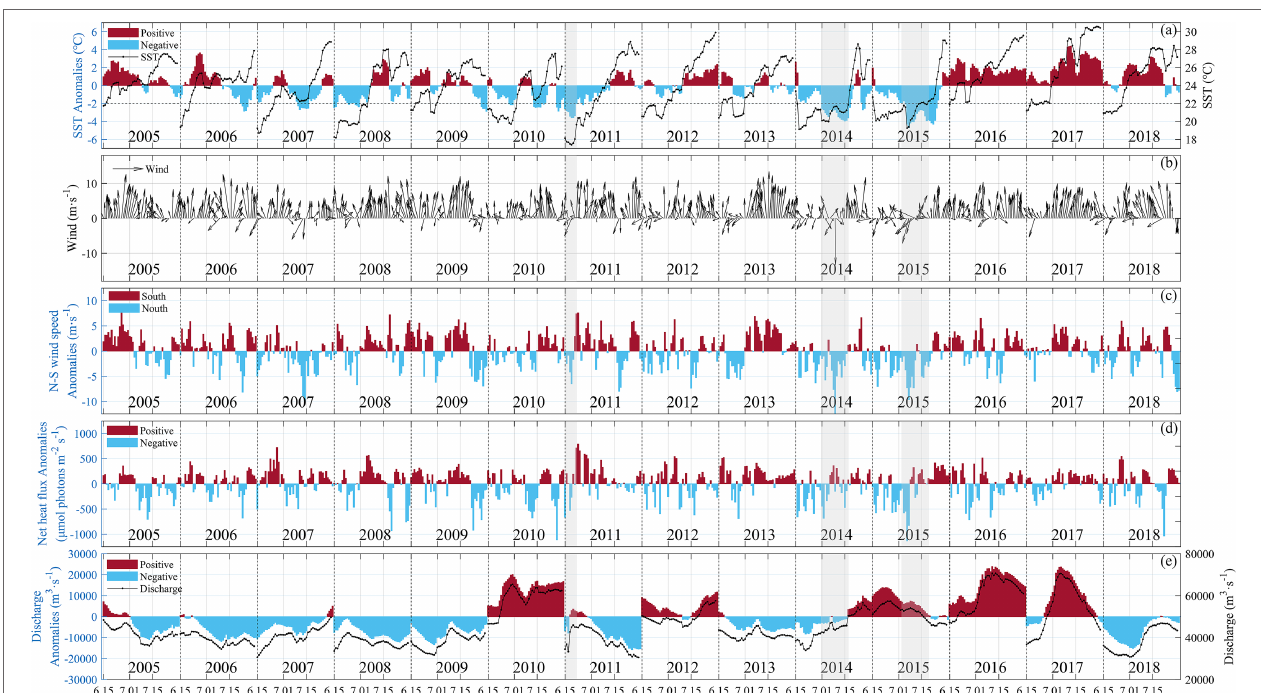
FIGURE 5 | Temporal variations of daily SST and SST anomalies (A) , wind (B) , North-South (N-S) speed anomalies (C) , and net heat flux anomalies (D) at central of the CWZ (123.5°E, 32°N); and discharge and discharge anomalies at Datong station (E) . The gray shaded regions indicate the formation period of the